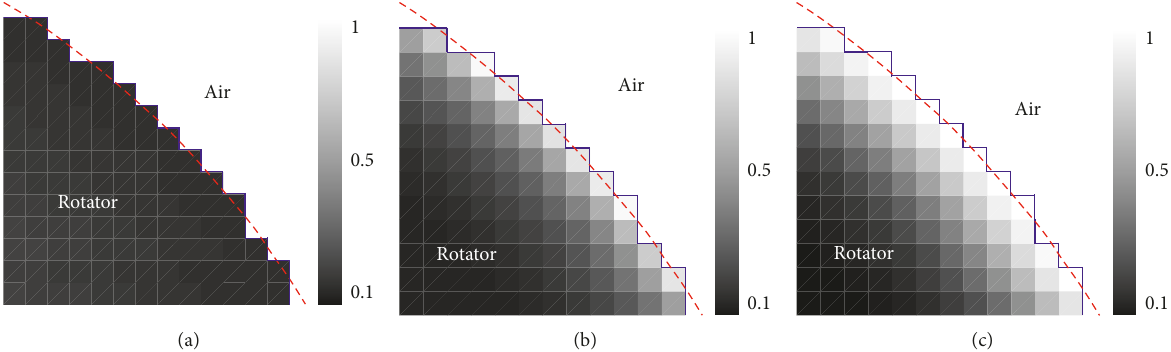
Figure 6: The ε r component of the field rotator around the R 2 boundary: (a) the linear function, (b) the third-order function, and (c) the fifth-order function. The circular boundary (red dashed line) was approximated to a stair-cased boundary (solid blue